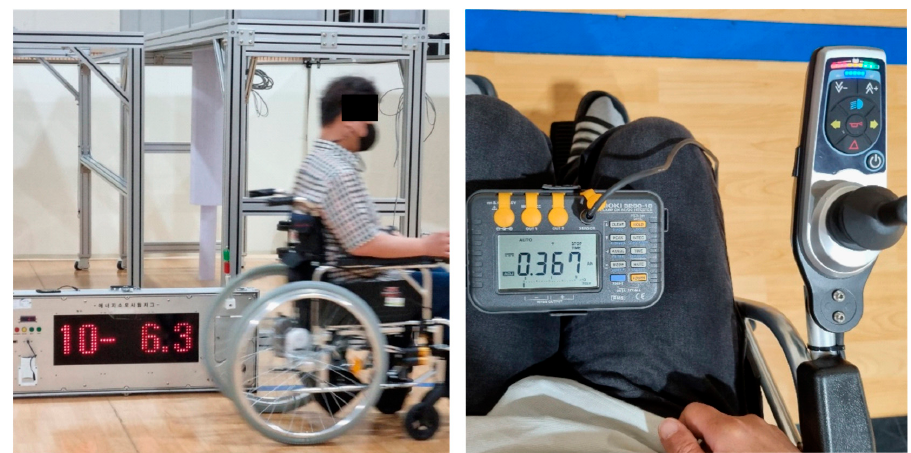
Figure 11. Maximum speed test and consumption test of the wheelchair.